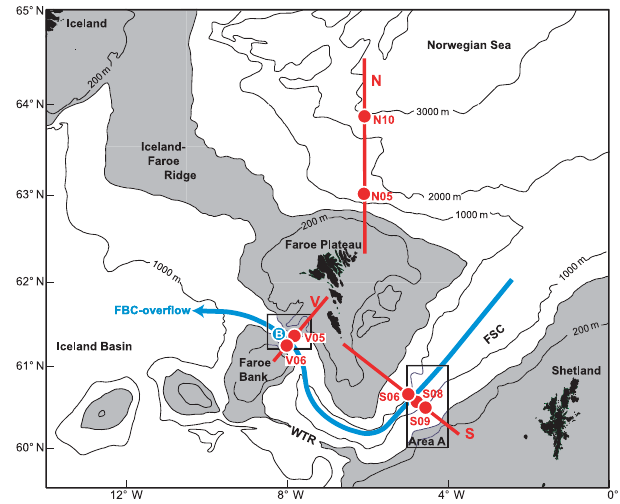
Figure 1. Map of the region with gray areas shallower than 500m. Blue arrow indicates the path of the FBC overflow through the Faroe–Shetland Channel (FSC), after which it is turned northwest- wards by the Wyville Thomson Ridge (WTR) to flow through the FBC between the Faroe Plateau and Faroe Bank. Red lines indicate three standard sections (V, S, and N) with selected standard CTD stations indicated by red circles. Blue circle labeled “B” indicates the long-term mooring site FB over the sill of the FBC. Black rect- angle over the sill and section V show area that is illustrated in more detail in Fig. 2. Black rectangle over section S shows area A, from which CTD stations deeper than 600m have been